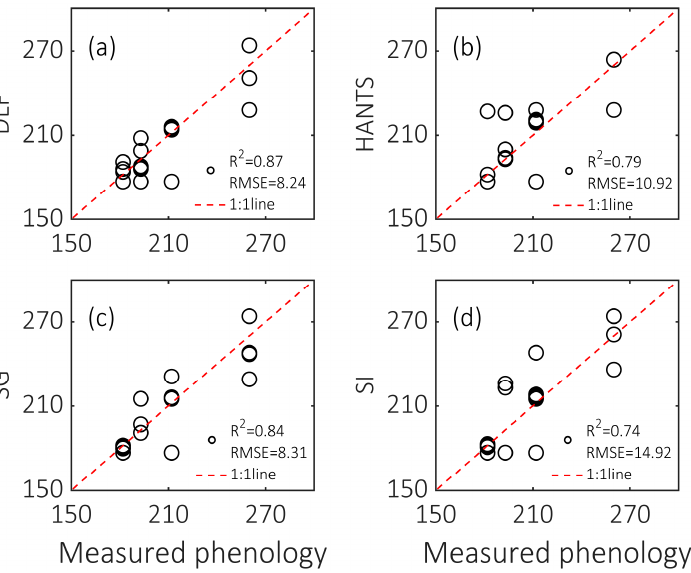
Figure A3. Comparison of extracted and observed phenology from ground observations of maize using different filtering methods at the site in Shangqiu in 2020. Note: ( a – d ) represented the comparison of extracted phenology using DLF, HANTS, SG, and SI, respectively.